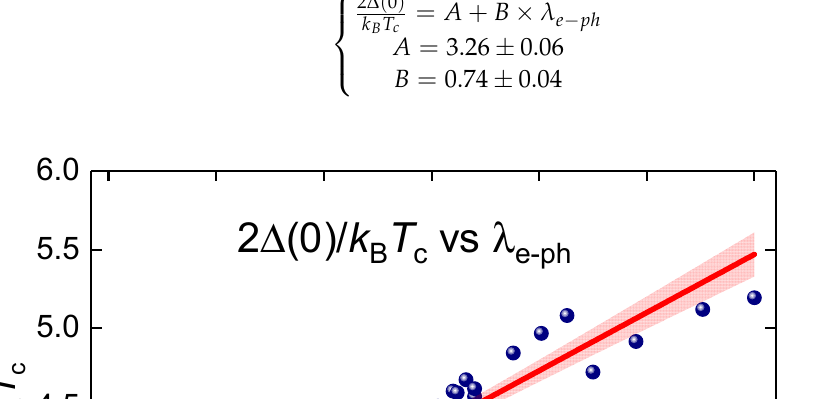
(cid:2870)⋅(cid:2940)(cid:4666)(cid:2868)(cid:4667) · ∆ ( 0 ) = 3.53 is shown by = 3.53 is shown by green (cid:3038) (cid:3251) ⋅(cid:3021) (cid:3278) k B · T c